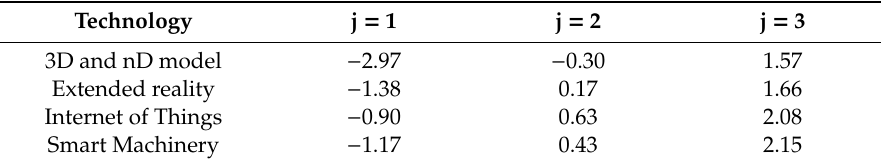
Table 6. α j value of di ff erent technology type for China.